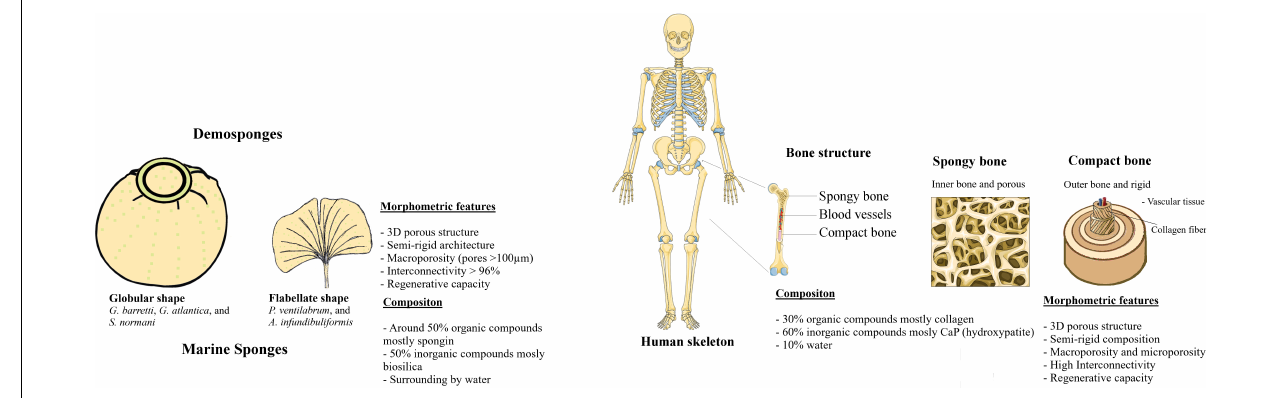
FIGURE 11 | Comparative morphological features of Marine Sponges and Human Bone